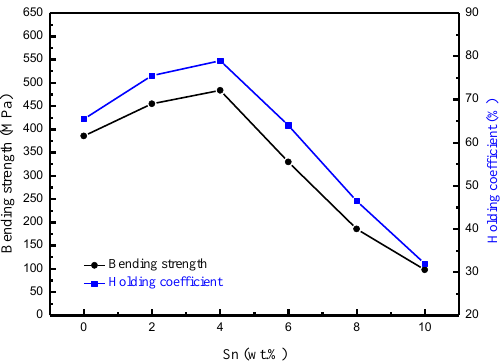
Figure 9. The e ff ect of Sn content on the bending strength of diamond tools and holding coe ffi cient of Figure 9. The effect of Sn content on the bending strength of diamond tools and holding coefficient of the sintered matrix on diamond. the sintered matrix on diamond.